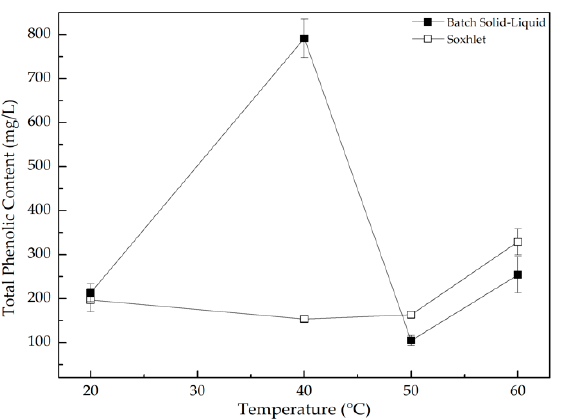
Figure 1. Total phenolic content results for batch solid-liquid ( ■ ) and Soxhlet ( □ ), 3 days leaf extraction, using four different drying temperatures: 20, 40, 50 and 60 °C.